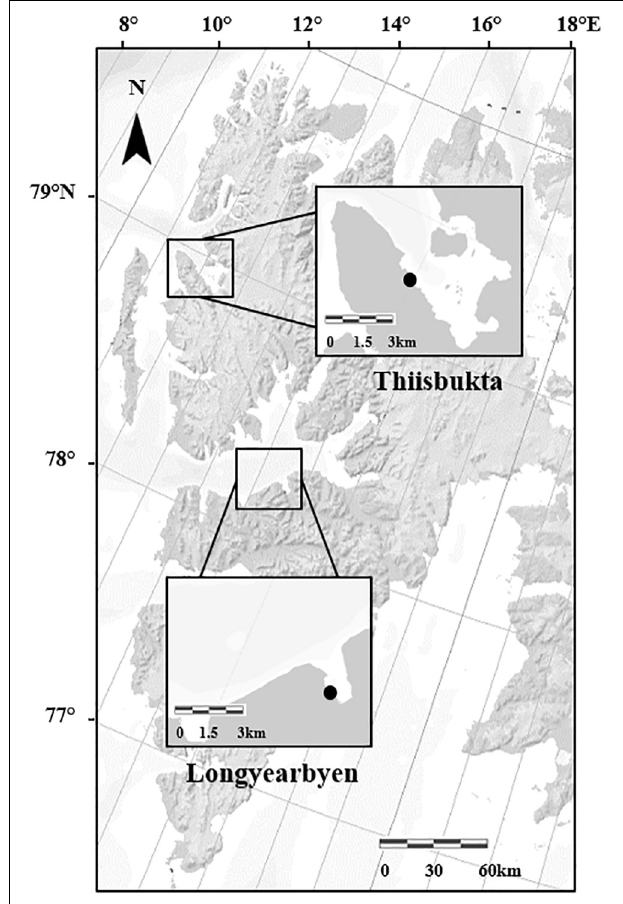
FIGURE 1 | Map of the Svalbard Archipelago with marked study areas, and the black points indicate the study sites Longyearbyen and Thiisbukta (Norwegian Polar Institute/https://geokart.npolar.no/).